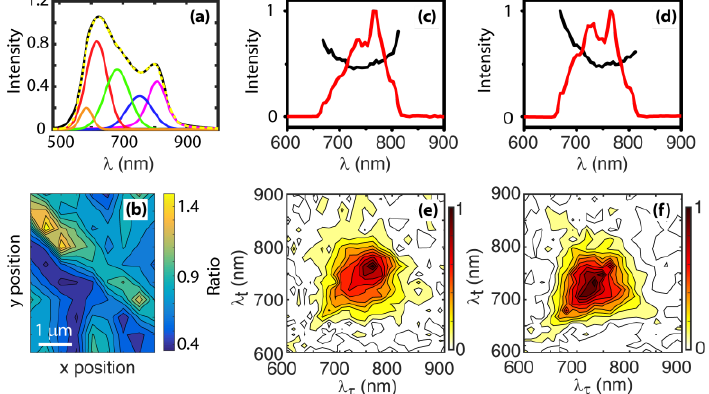
Fig. 1. (a) Absorption spectrum (black solid line) of a planar F 16 ZnPc film, fitting curve (yellow dotted line) with multiple component peaks plotted in different colors. (b) Map of ratio between intensities at 700 and 770 nm in linear spectra. (c, d) Spatially resolved linear product spectra (red) and excitation spectra (black) from two exemplary positions of the sample. (e, f) Corresponding spatially resolved 2D absorptive spectra from the two exemplary